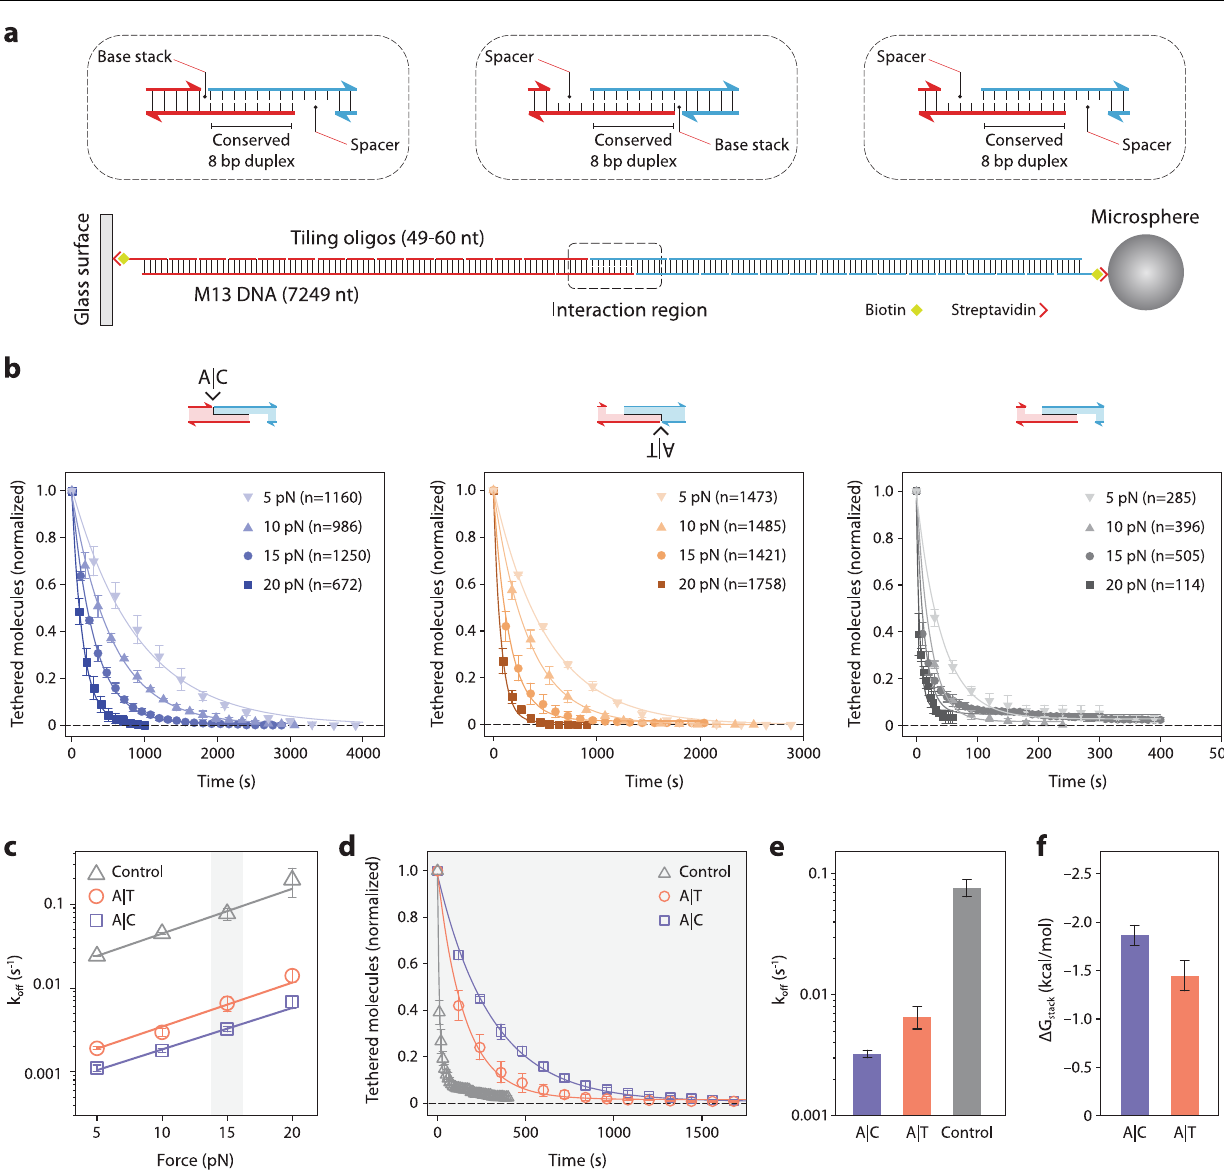
distances of 0.47±0.04nm, 0.49±0.05nm, and 0.51±0.01nm, respectively. d Analysisofthethreeconstructsat15pNshowscleardifferencesindissociation, fi t withexponentialdecaycurvestoyieldoff-rates( e ),fromwhich Δ G stack iscalculated ( f ). Data in ( b – e ) presented as mean values +/ − standard deviation from three independent data sets (shown in Supplementary Figs. 2 – 4). Data in ( f ) calculated from mean values +/ − propagated errors from ( e ). n represents the number of individual molecular